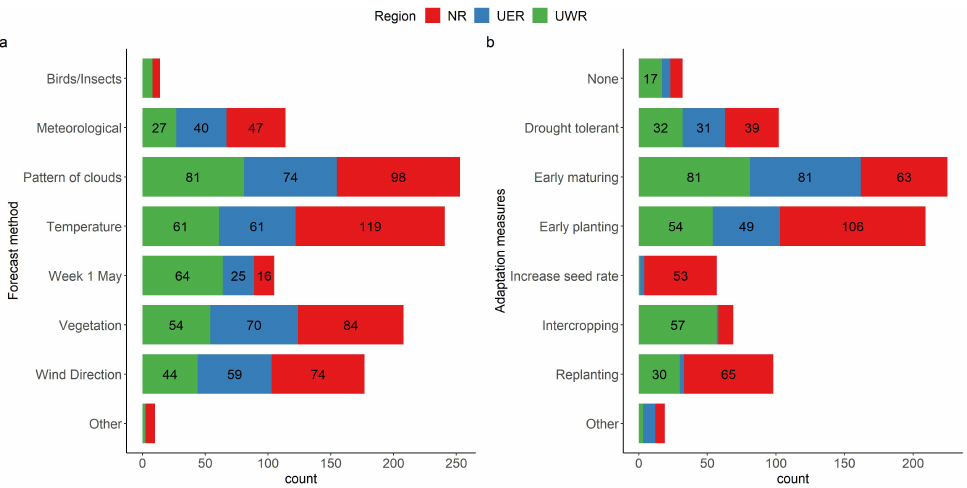
Figure 10. Farmers’ responses on the methods applied to forecast the season’s onset ( a ) and the adaptation measures to cope with observed trends on the onset and cessation of rainfall ( b ) in northern